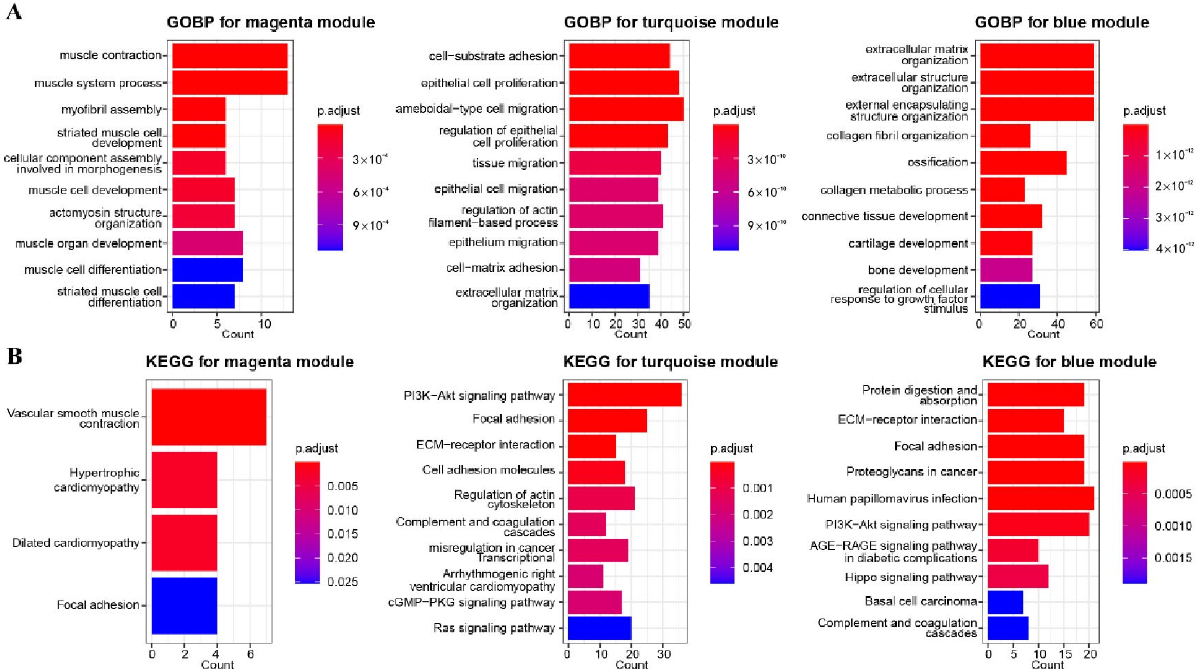
Figure 2. Enrichment analysis of related gene modules. ( A ) GOBP analysis for magenta, turquoise, and blue modules. ( B ) KEGG analysis for magenta, turquoise, and blue modules. and blue modules. ( B ) KEGG analysis for magenta, turquoise, and blue